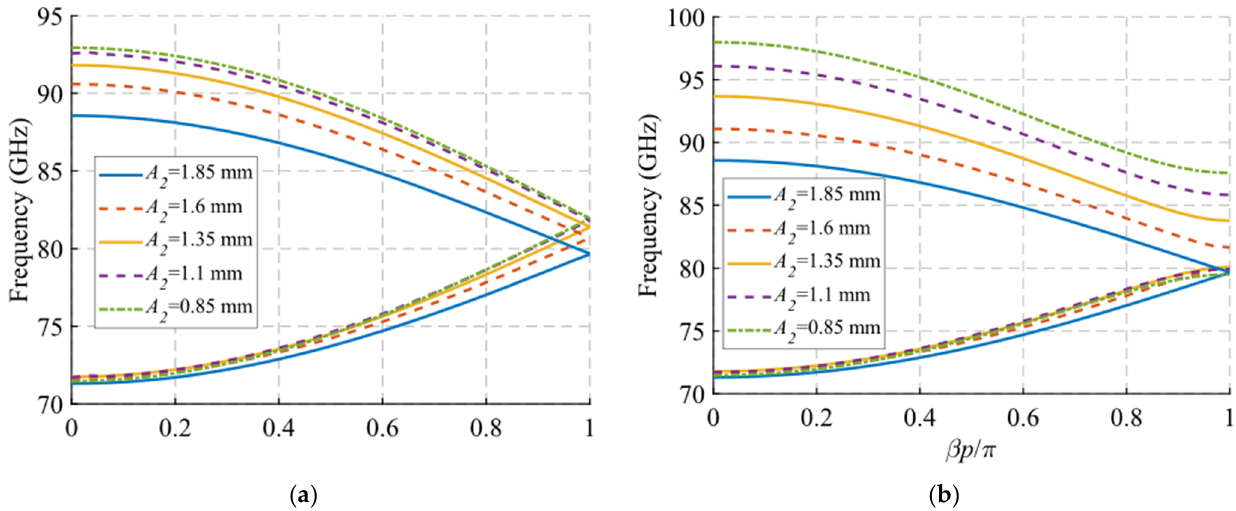
Figure 12. Dispersion diagram of the single-periodic unit cell for various values of A 2 . ( a ) Glide- symmetric configuration ( d = 0.725 mm) and ( b ) maximum rupture of symmetry configuration ( d = 0 mm).